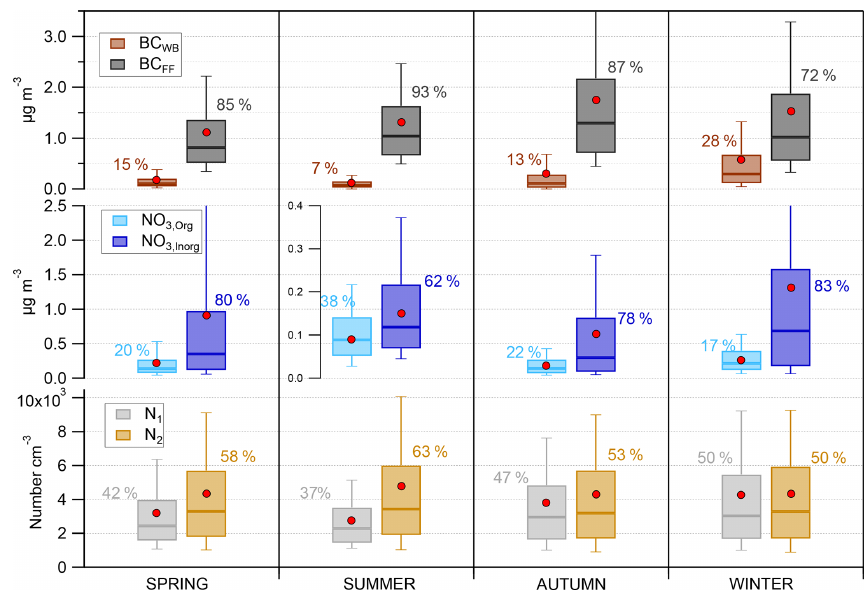
Figure 4. Seasonal concentrations for the different fractions of BC (BC WB and BC FF ), NO − between 20 and 100nm ( N 1 , N 2 ) represented as box plots. The band inside the box is the median (50th percentile); the bottom and top of the box represent the lower and upper quartiles, respectively (the 25th and 75th percentiles). The ends of the whiskers denote here the 10th and 90th percentiles. The red dots refer to the mean of each